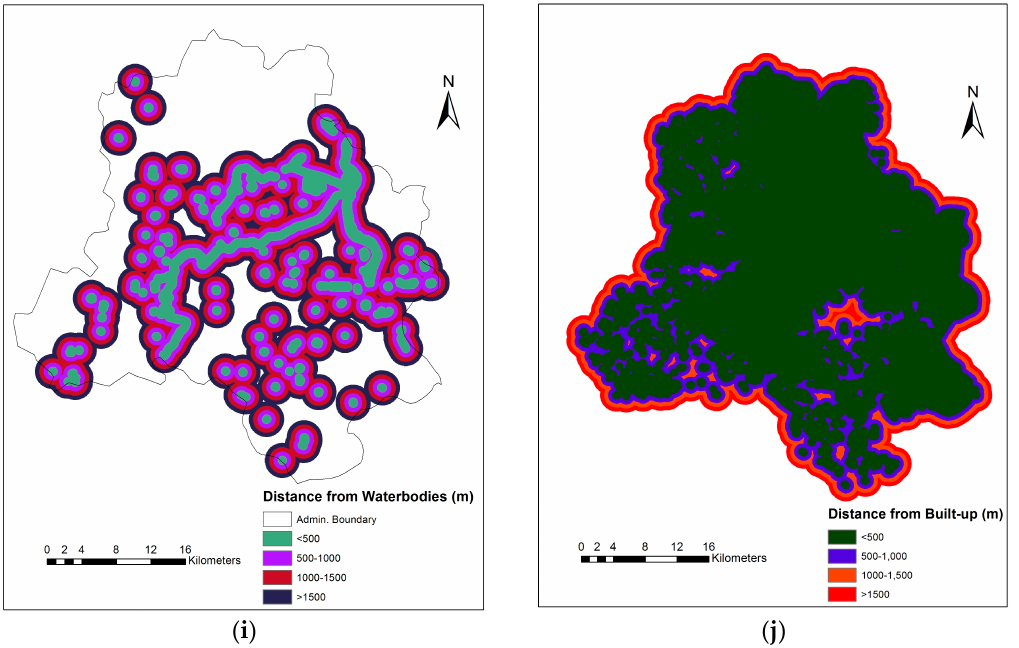
Figure 4. ( a – e ) Network map of all the factors; ( f – j ) Distance Buffer map of all the factors.